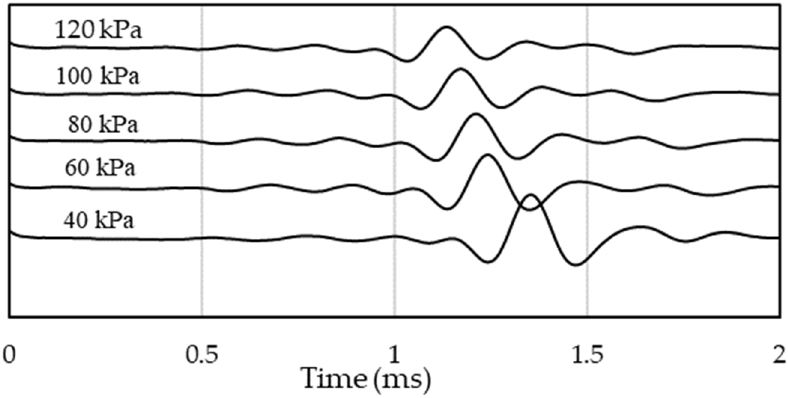
Figure 2. Typical receiver signals (staked) from the Bender Element testing at different confinements for sample SB.